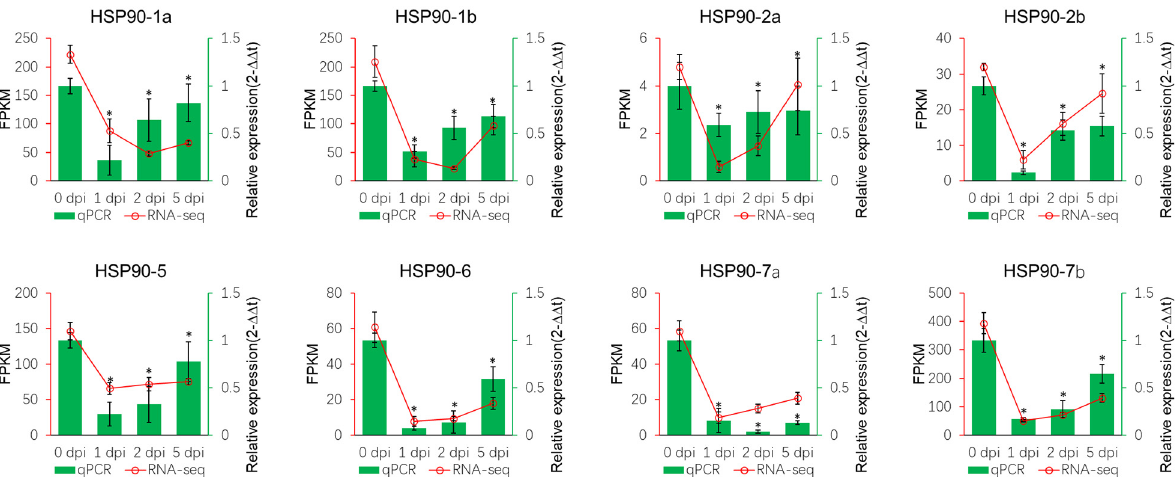
Figure 3. Expression of HSP90 genes in M. sieversii during V. mali infection. The normalized expression level (FPKM) from the RNA-seq data were shown in red line on right vertical axis and relative expression level from qPCR were shown in green bar on right vertical axis. Verification of the expression of MdHSP90s in M. sieversii under V. mali infection by qRT-PCR. MsEF1- α was used as an internal reference gene. The relative expression data were analyzed by one-way ANOVA method. “*” represented significantly different ( p < 0.05, n = 3), and error bars indicate mean ±SE.